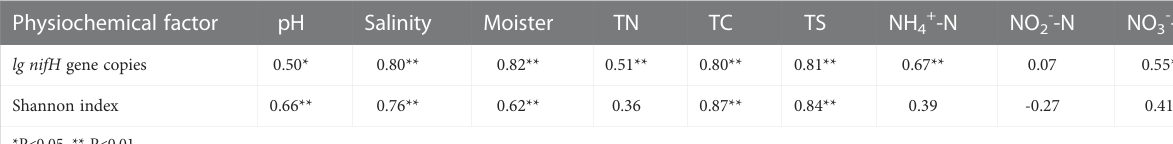
TABLE 3 Spearman ’ s correlation between the physiochemical factors and community structure of nitrogen- fi xing bacteria. Physiochemical